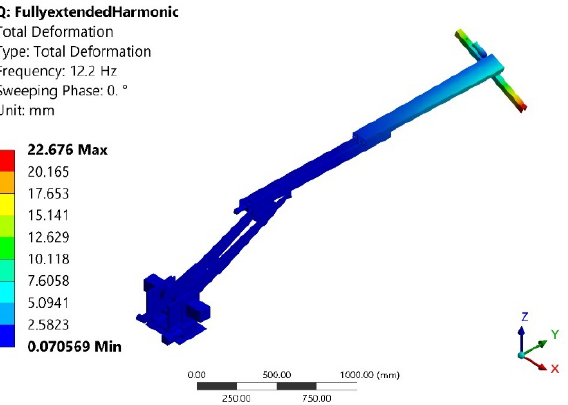
Figure 15. Total deformation (in mm) of the fully-extended configuration structure resulting from the harmonic analysis at the 3rd natural frequency (12.2 Hz).